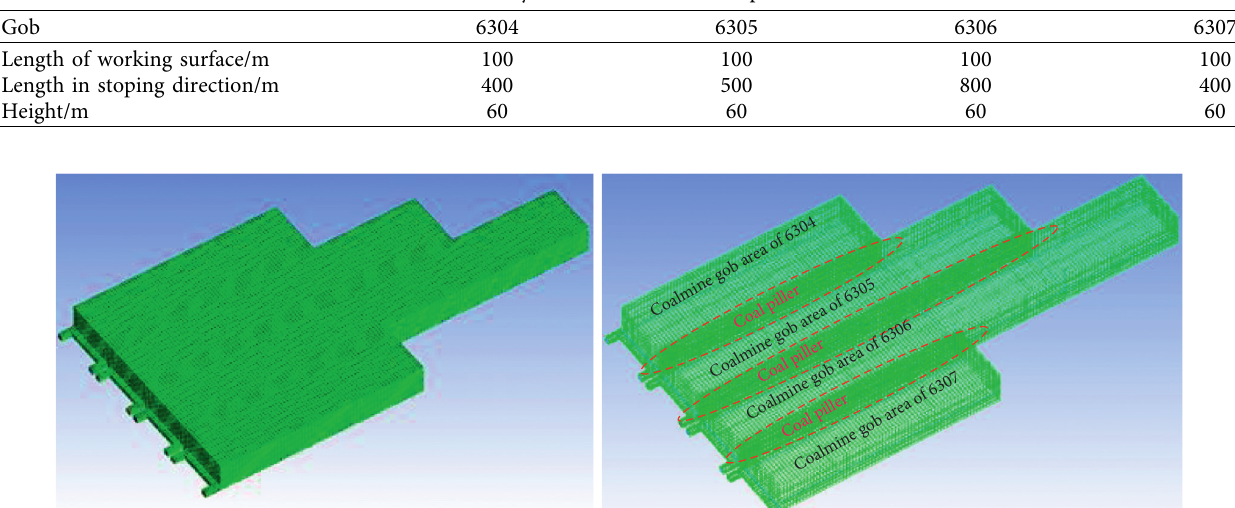
Table 4: Summary of dimensions of each part of model.